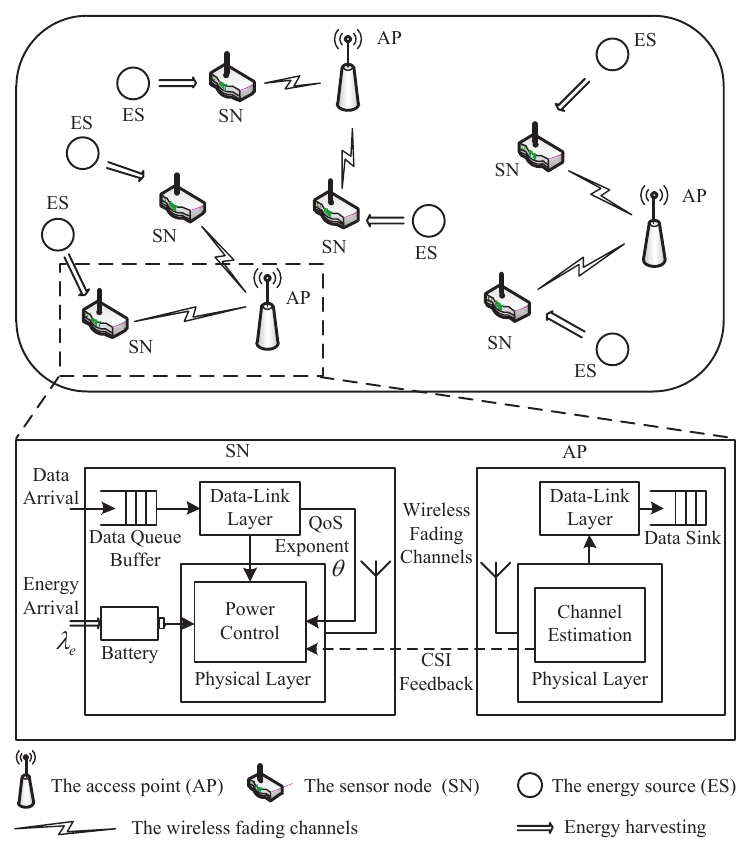
Figure 1. The system model for energy harvesting wireless sensor